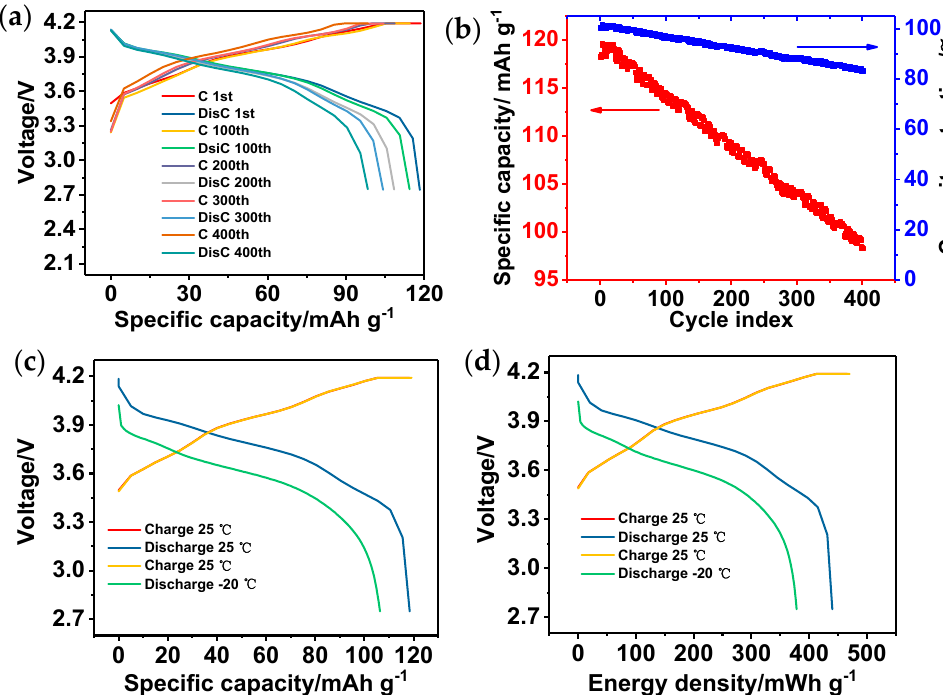
Figure 3. The charge–discharge performance of a normal device: ( a ) charge–discharge curves at 1 C (100 mA g − 1 ) and 25 °C for 1st, 100th, 200th, 300th, and 400th cycle; ( b ) specific capacity and its retention over 400 cycles at 1 C (100 mA g − 1 ) and 25 °C; ( c ) the first charge–discharge cycle curves at 1 C (100 mA g − 1 ) and 25 °C and at 0.2 C (20 mA g − 1 ) and − 20 °C; ( d ) the first energy density cycle curves at 1 C (100 mA g − 1 ) and 25 °C and at 0.2 C (20 mA g − 1 ) and − 20 °C.